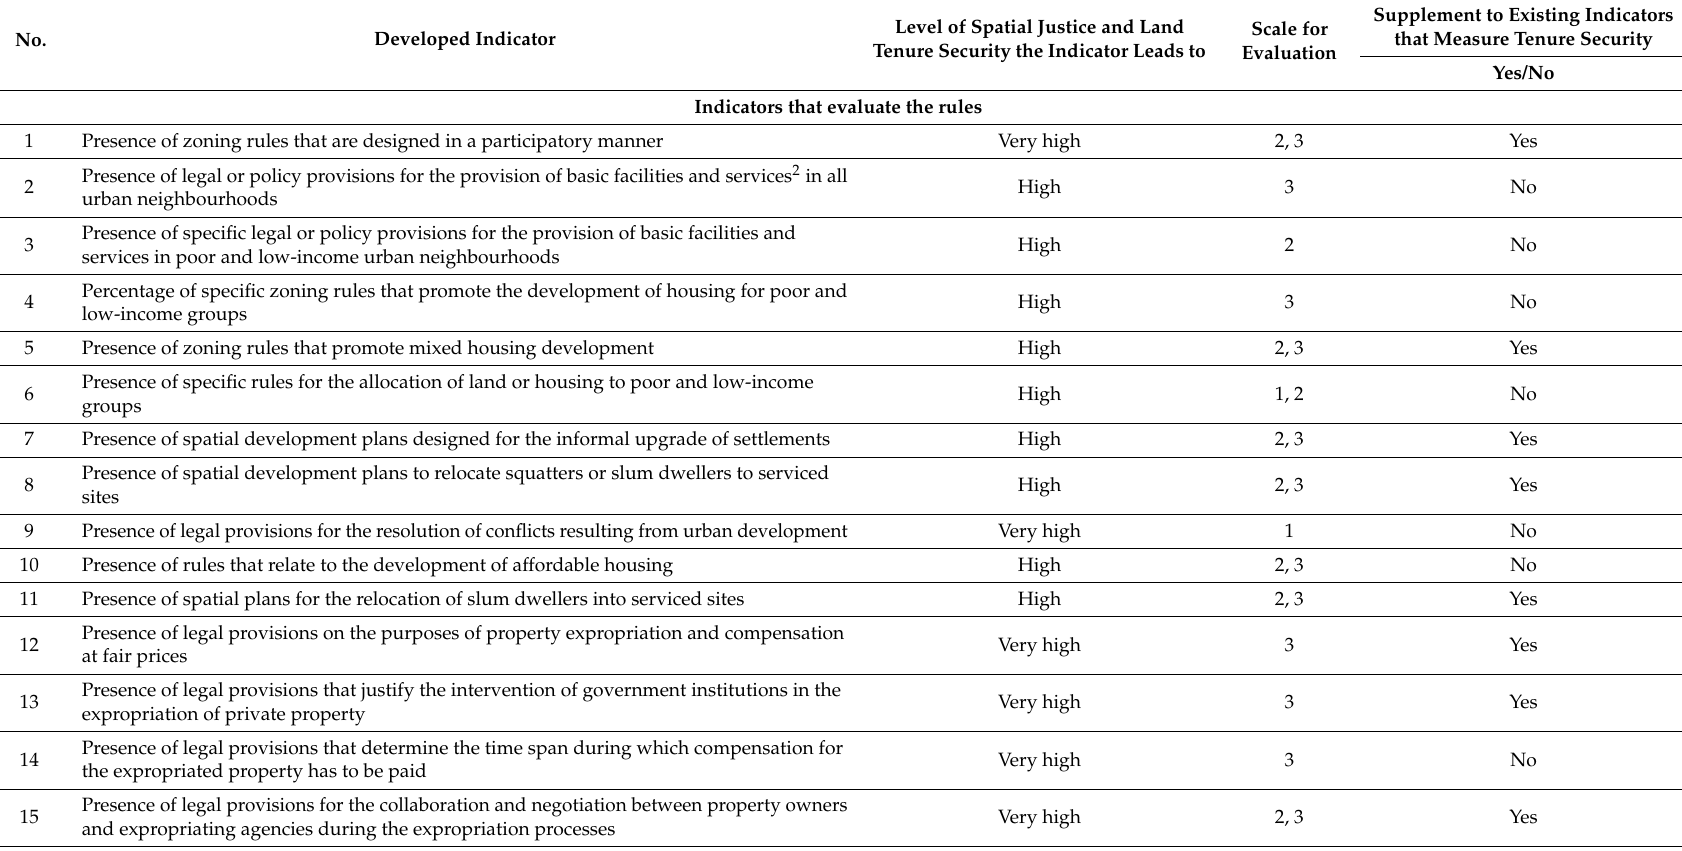
Table 3. Evaluative indicators for spatial justice and land tenure